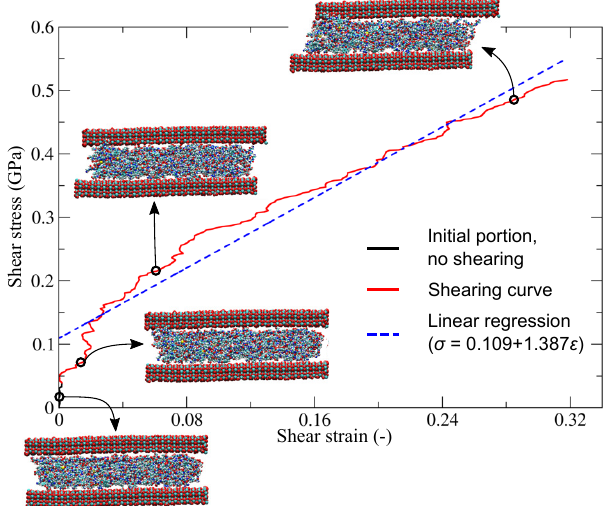
Figure 3. Shear stress versus shear strain curve for the combined model. The initial part of the curve (black) shows nearly no displacement of the upper aragonite tablet. Linearization of the shearing curve is shown with the blue dotted line. Snapshots show the shearing of the organic matrix taken at strains that are marked by